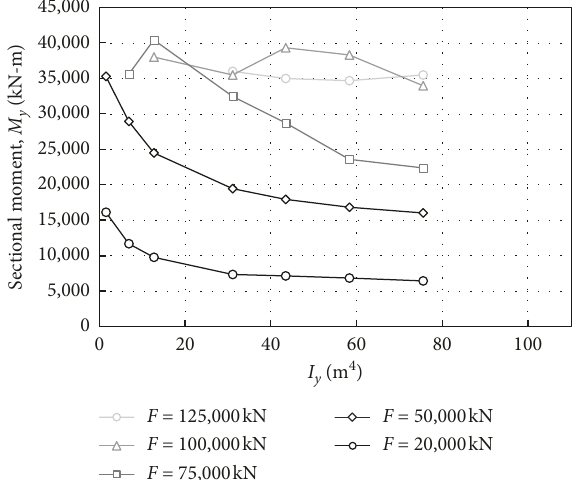
Figure 12: Sectional moment, M y , of the substructure member (pier 3) along with abutment